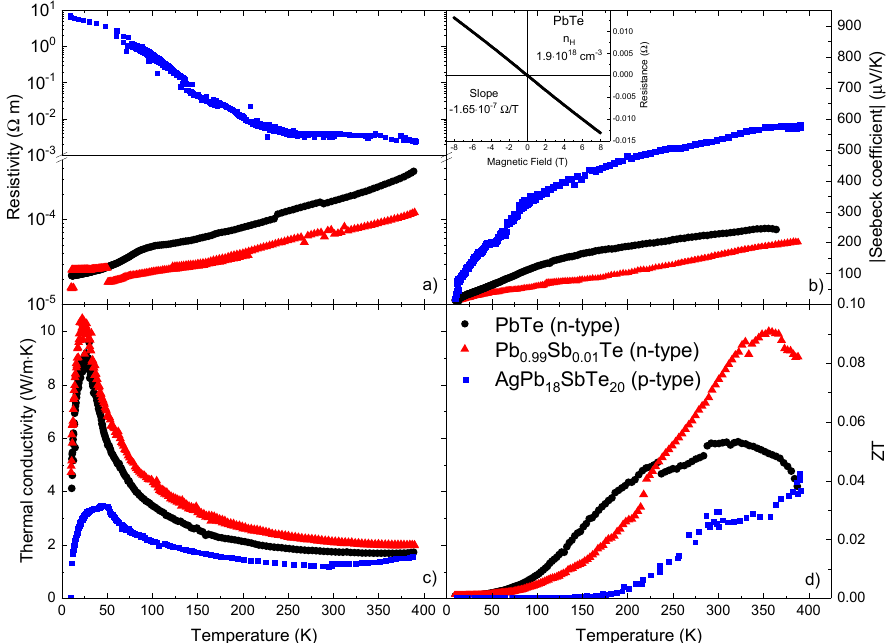
Figure 5. ( a ) Resistivity, ( b ) Seebeck coefficient, ( c ) thermal conductivity, and ( d ) figure of merit versus temperature for PbTe, Pb 0.99 Sb 0.01 Te, and LAST18 prepared by arc melting. The inset in ( c ) shows the Hall Effect measurement of the pristine